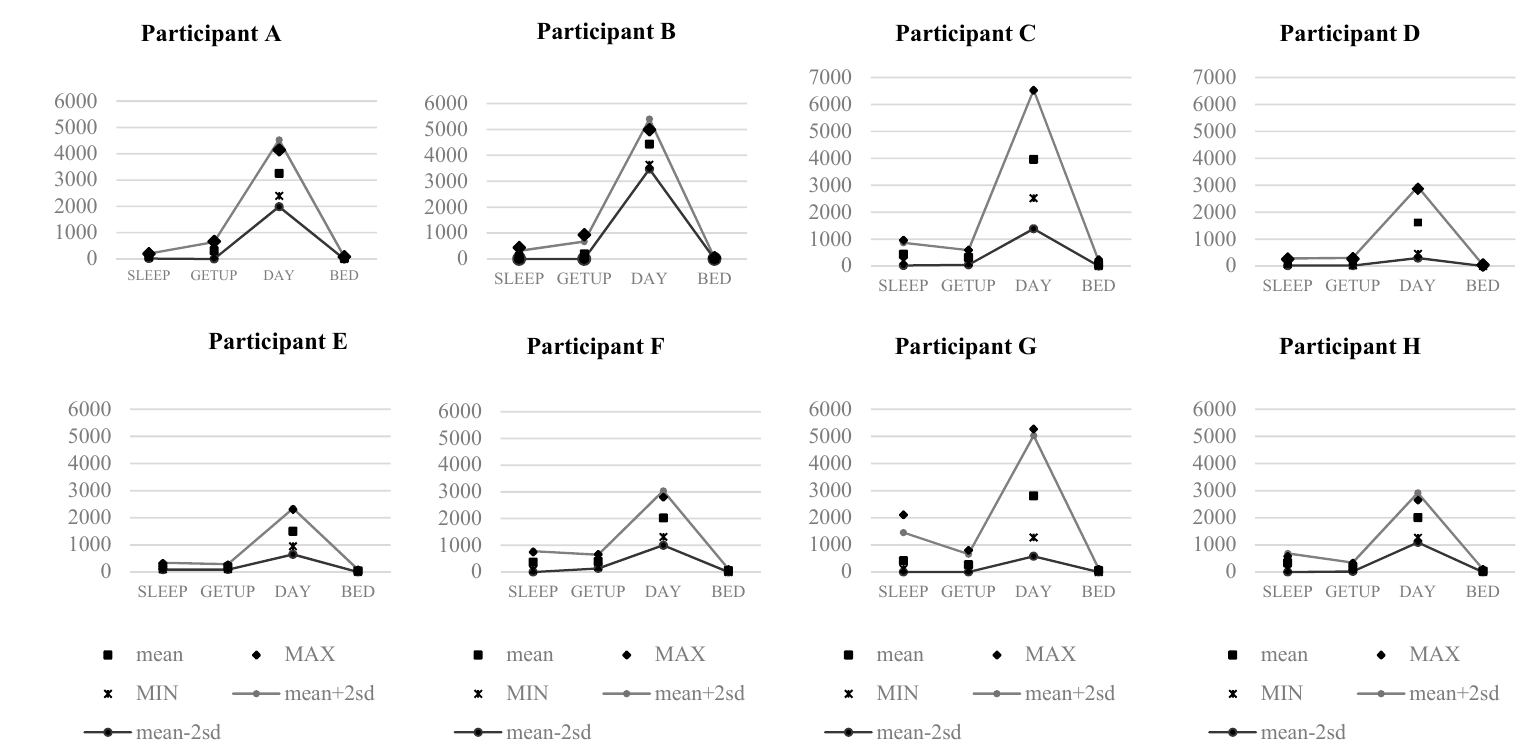
Figure 2. Patterns of daily indoor activities during the initial 14-day baseline period. SLEEP: the average of sensor outputs during sleep; GETUP: the average of sensor outputs at the point of time of wake-up; DAY: the average of sensor outputs during the daytime; and BED: the average of sensor outputs at the point of time of going to bed